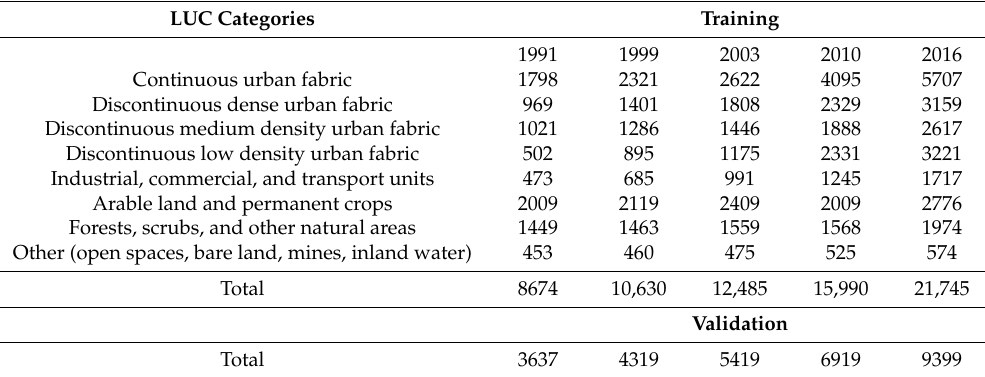
Table 2. Training and validation samples used for classification